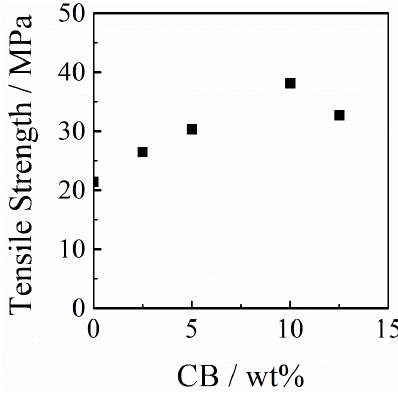
Figure 5. Variation of tensile strength as a function of the CB weight ratio in the PAI/PANI/CB ternary blend films.